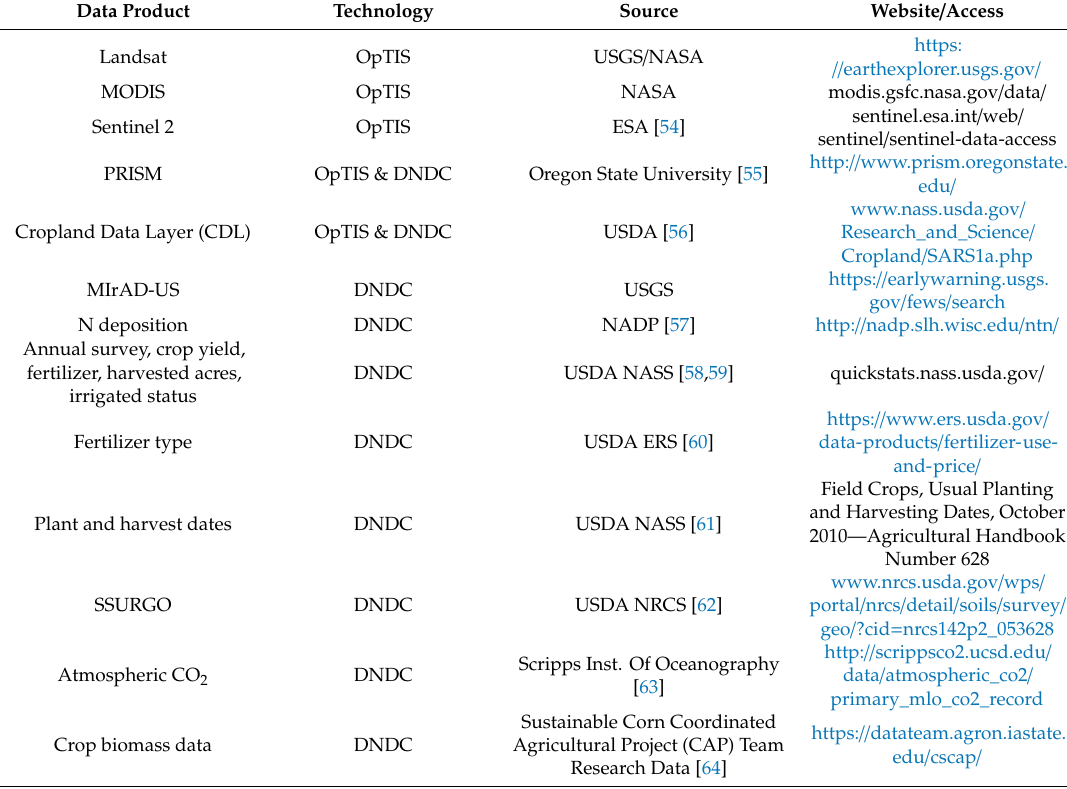
Table 1. Data used in OpTIS mapping of tillage practices, cover crops, and crop rotations, as well as for Denitrification–Decomposition model (DNDC) simulations of soil C, greenhouse gas (GHG) emissions, available soil moisture, and N